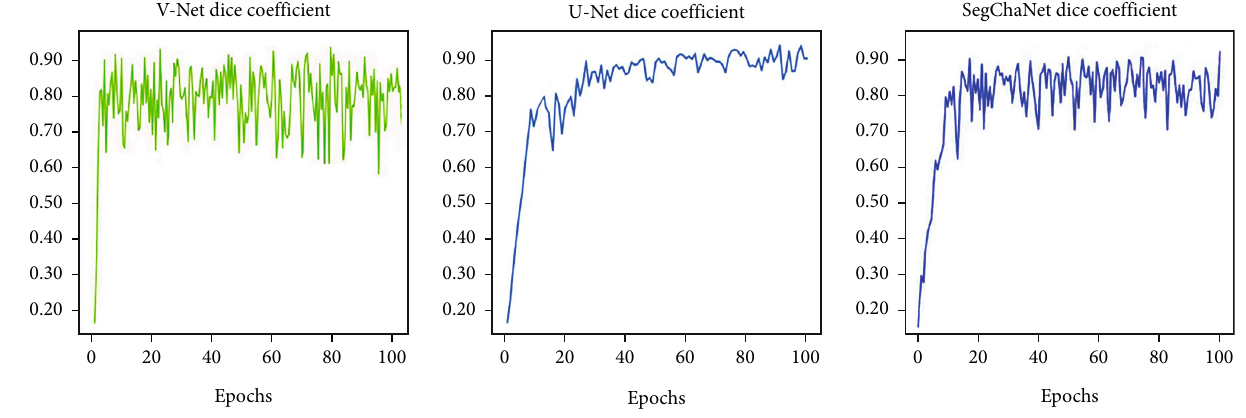
Figure 6: Applied model dice coe ffi